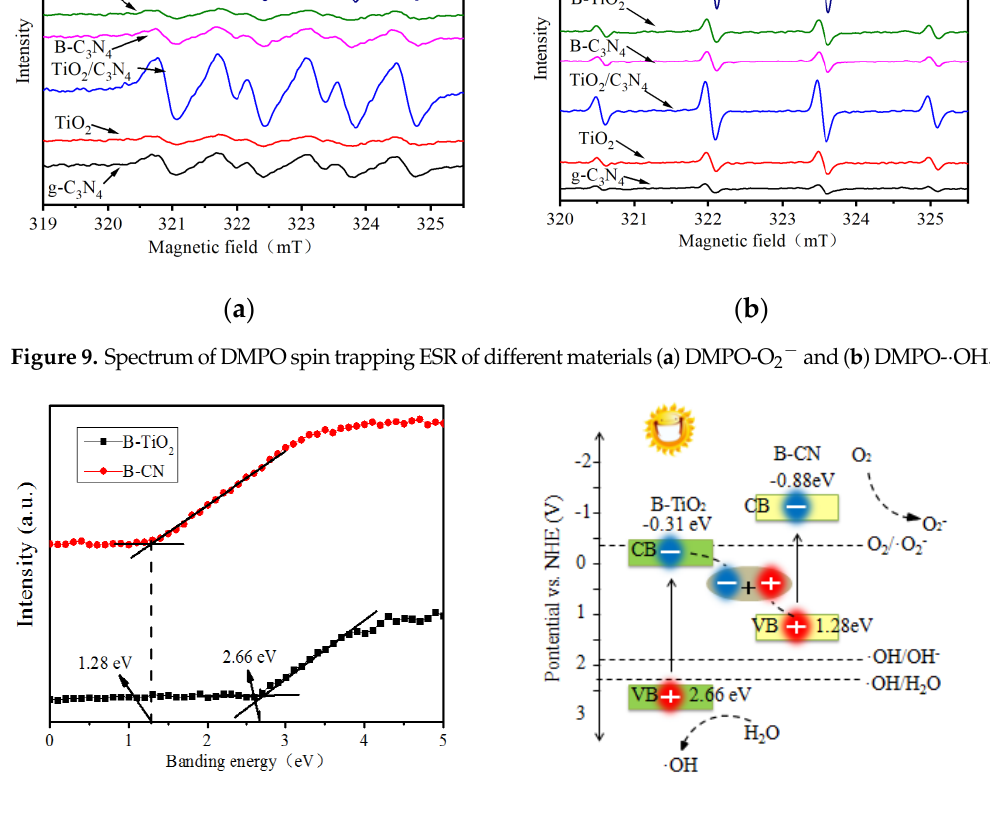
Figure 10. The photocatalytic reaction mechanism of B-TiO 2 /C 3 N 4 : ( a ) The VBXPS of B-TiO 2 and B-CN; ( b ) Scheme of proposed mechanism for degradation of B-TiO 2 /C 3 N 4 .